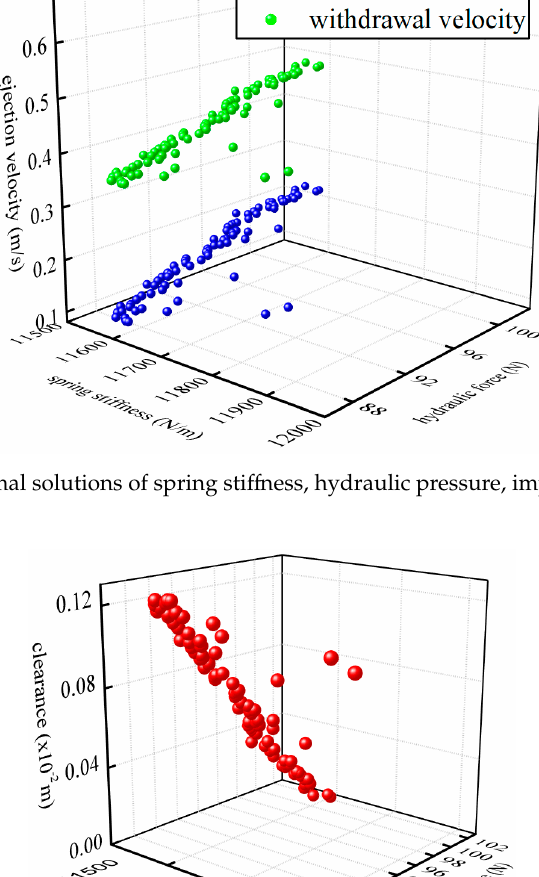
Figure 12. Pareto optimal solutions of spring stiffness, hydraulic pressure and backflow clearance.